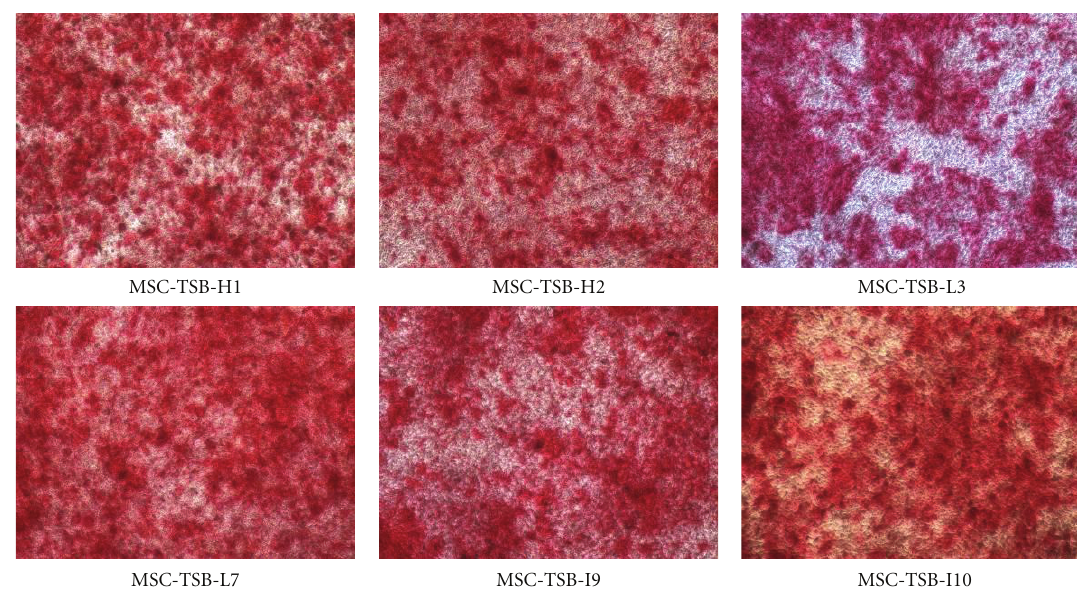
Figure 5: Osteogenic di ff erentiation as demonstrated by staining with Alizarin Red 21 days after induction, 10x